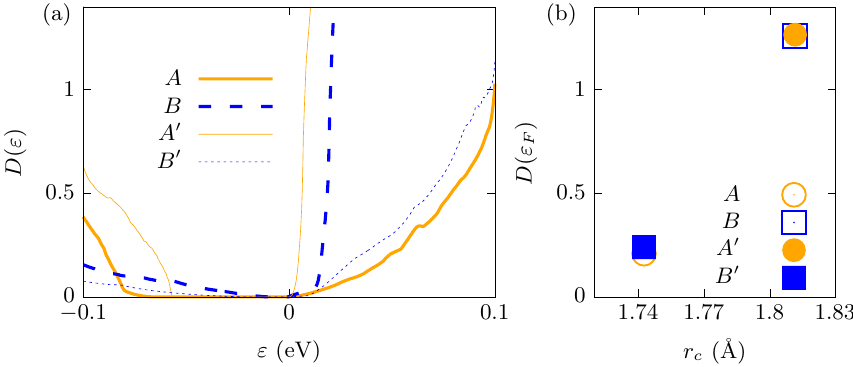
Figure 4: Panel (a): Density of states as a function of energy for the four models, A , B , A ′ , and B ′ . Panel (b): Density of states at the Fermi energy as a function of the Van der Waals gap r , for a doping of 1 × 10 19 electrons / cm 3 in all models. Models A and B c correspond to our own crystal refinement at 50 K and to Ref. [ 64 ] , respectively.